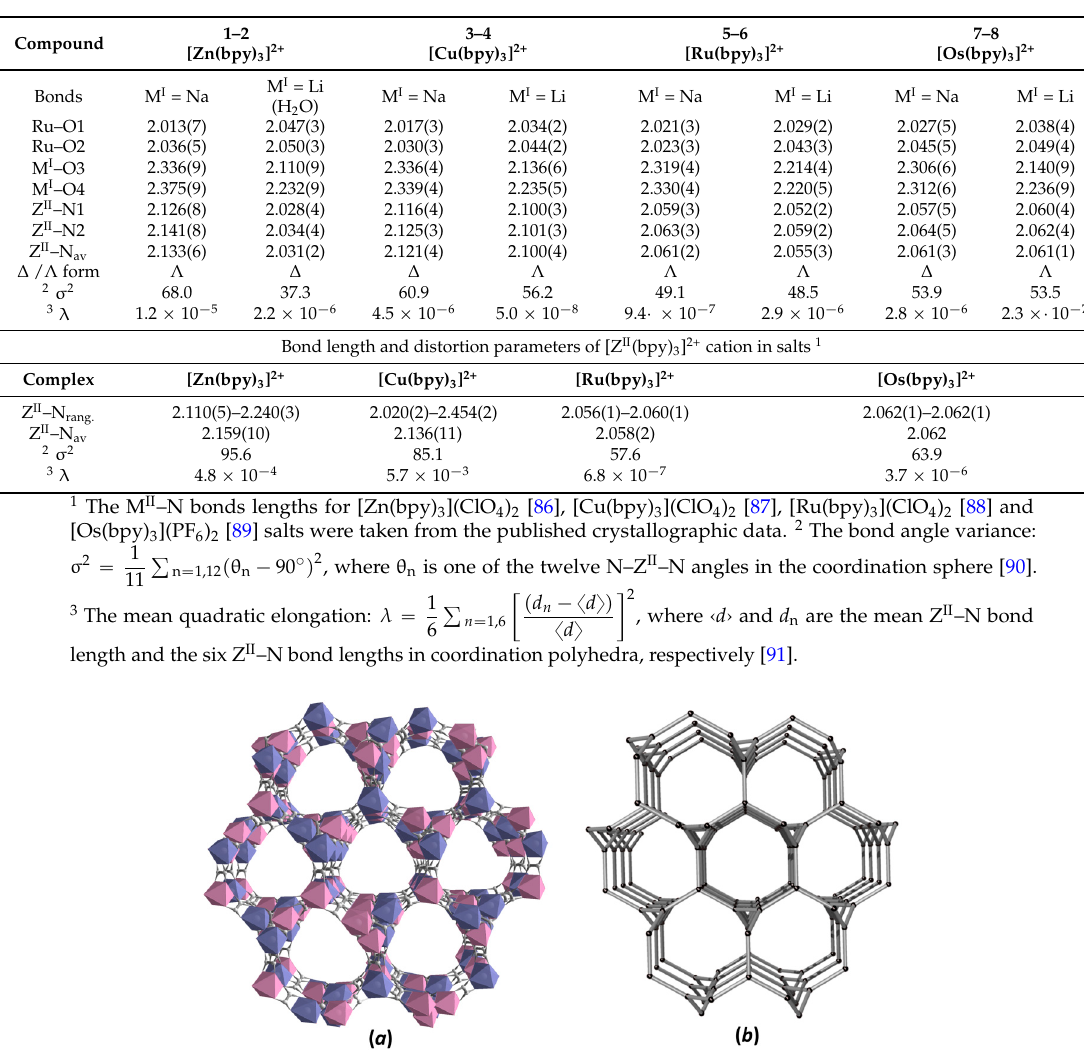
Figure 2. The 3D three-connected decagon anionic network {[M I Ru(C 2 O 4 ) 3 ] 2 − } n (M I = Na, Li): ( a ) view of honeycombed channels along the [111] direction and ( b ) its simplified topological representation, where black spheres represent a node of equivalent Ru III and M I centers.